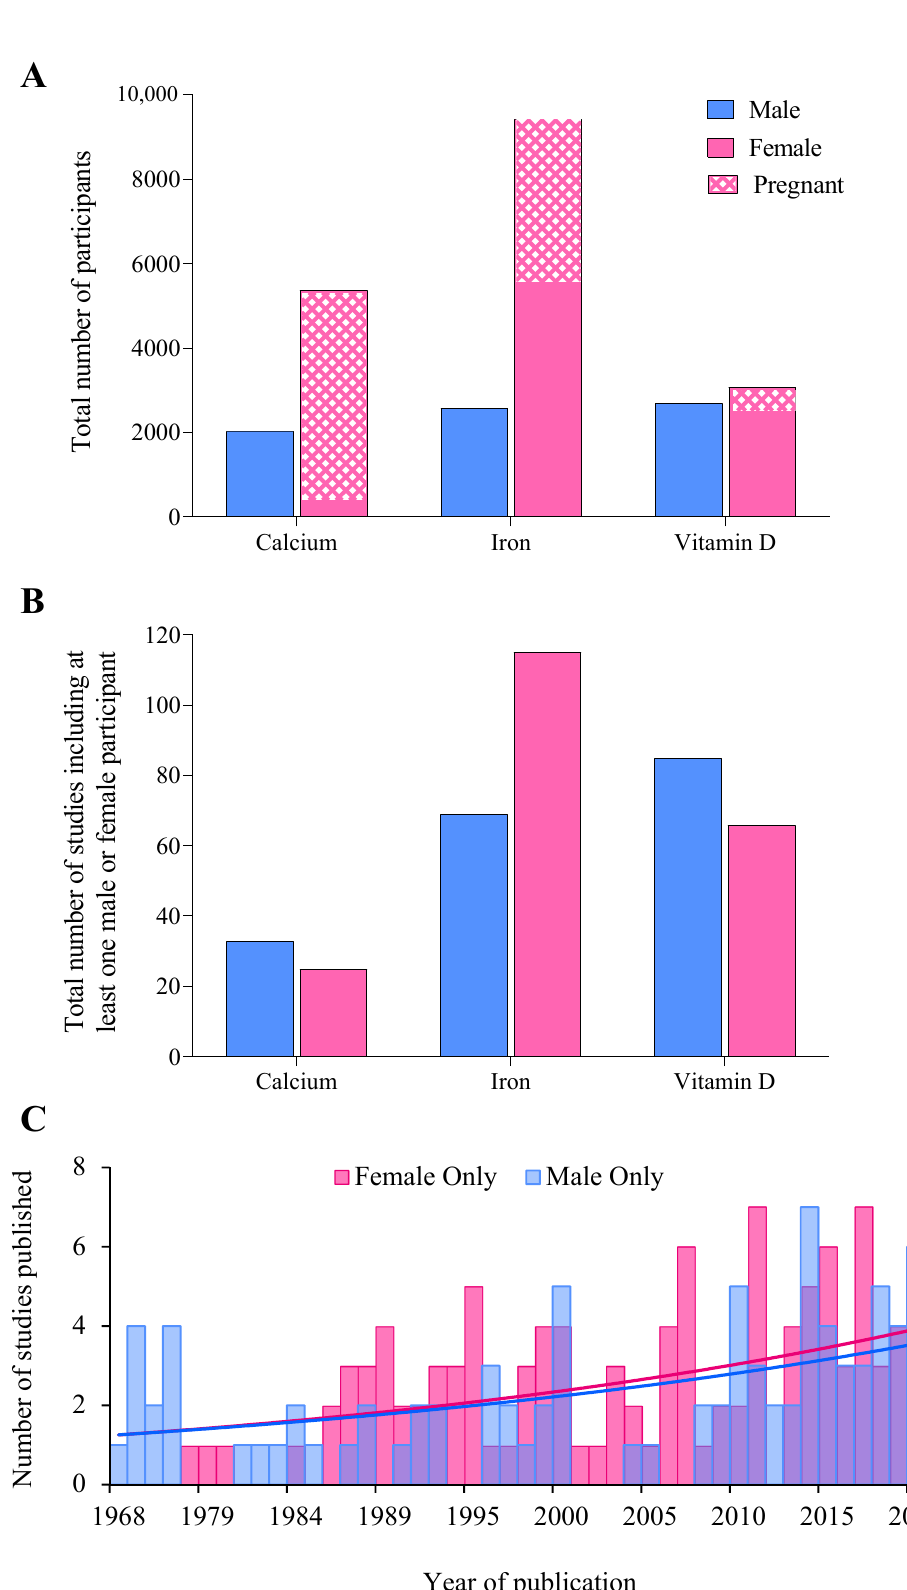
Figure 2. ( A ) The total number of male, female, and pregnant participants included across each supplement audited, ( B ) the total number of studies including at least one male or female participant, and ( C ) histogram displaying the total number of studies published in an exclusively male or female cohort between 1968 and 2021 across all supplements.